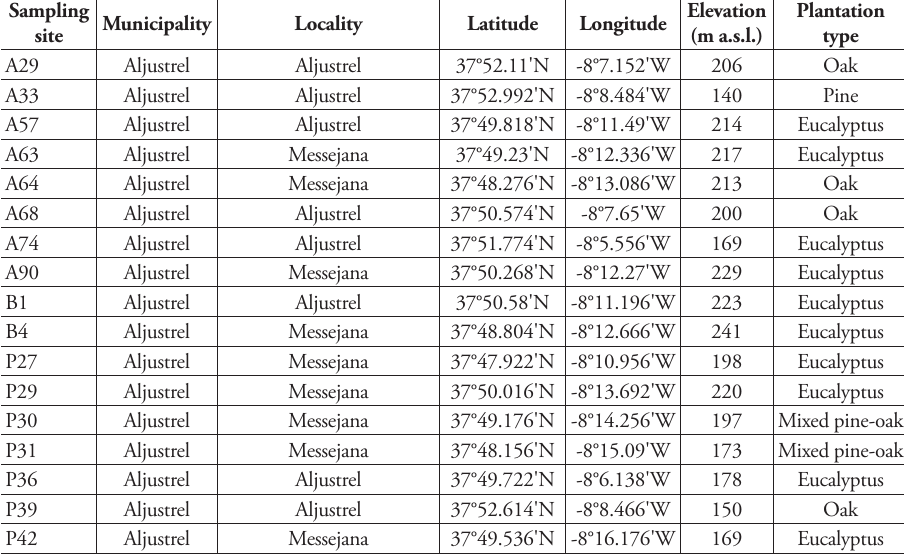
Figure 1. Location of the study area in southern Portugal showing the sites sampled (triangles), the Special Protection Area of Castro Verde, and the six municipalities encompassed. Table 1. Information on the sampling sites prospected in this study: site code, municipality, locality, WGS 84 coordinates, elevation and plantation type. Each coordinate corresponds to the centre of the edge between fallow and